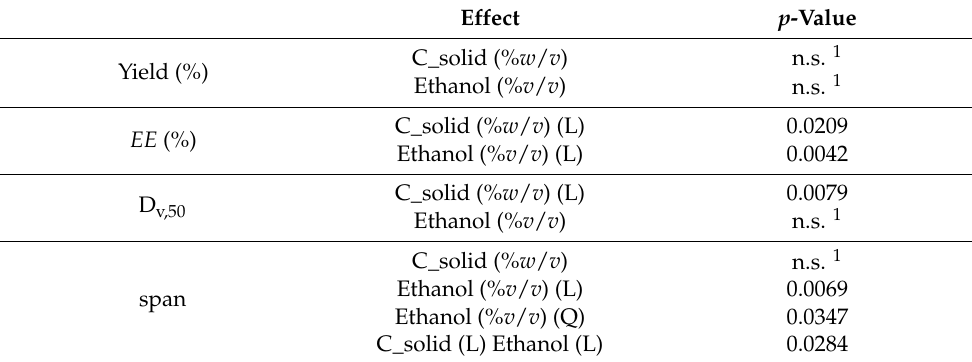
Table 2. Effects component (linear and or quadratic) with p -value obtained from ANOVA for each response studied in RSV–DPFs.